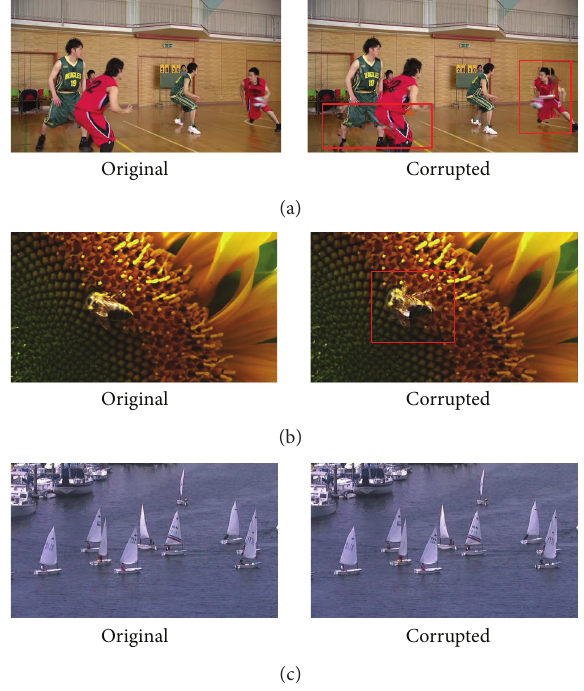
Figure 3: Packet loss in different video sequences. (a) Basket- ballDrive, (b) Sunflower , and (c)